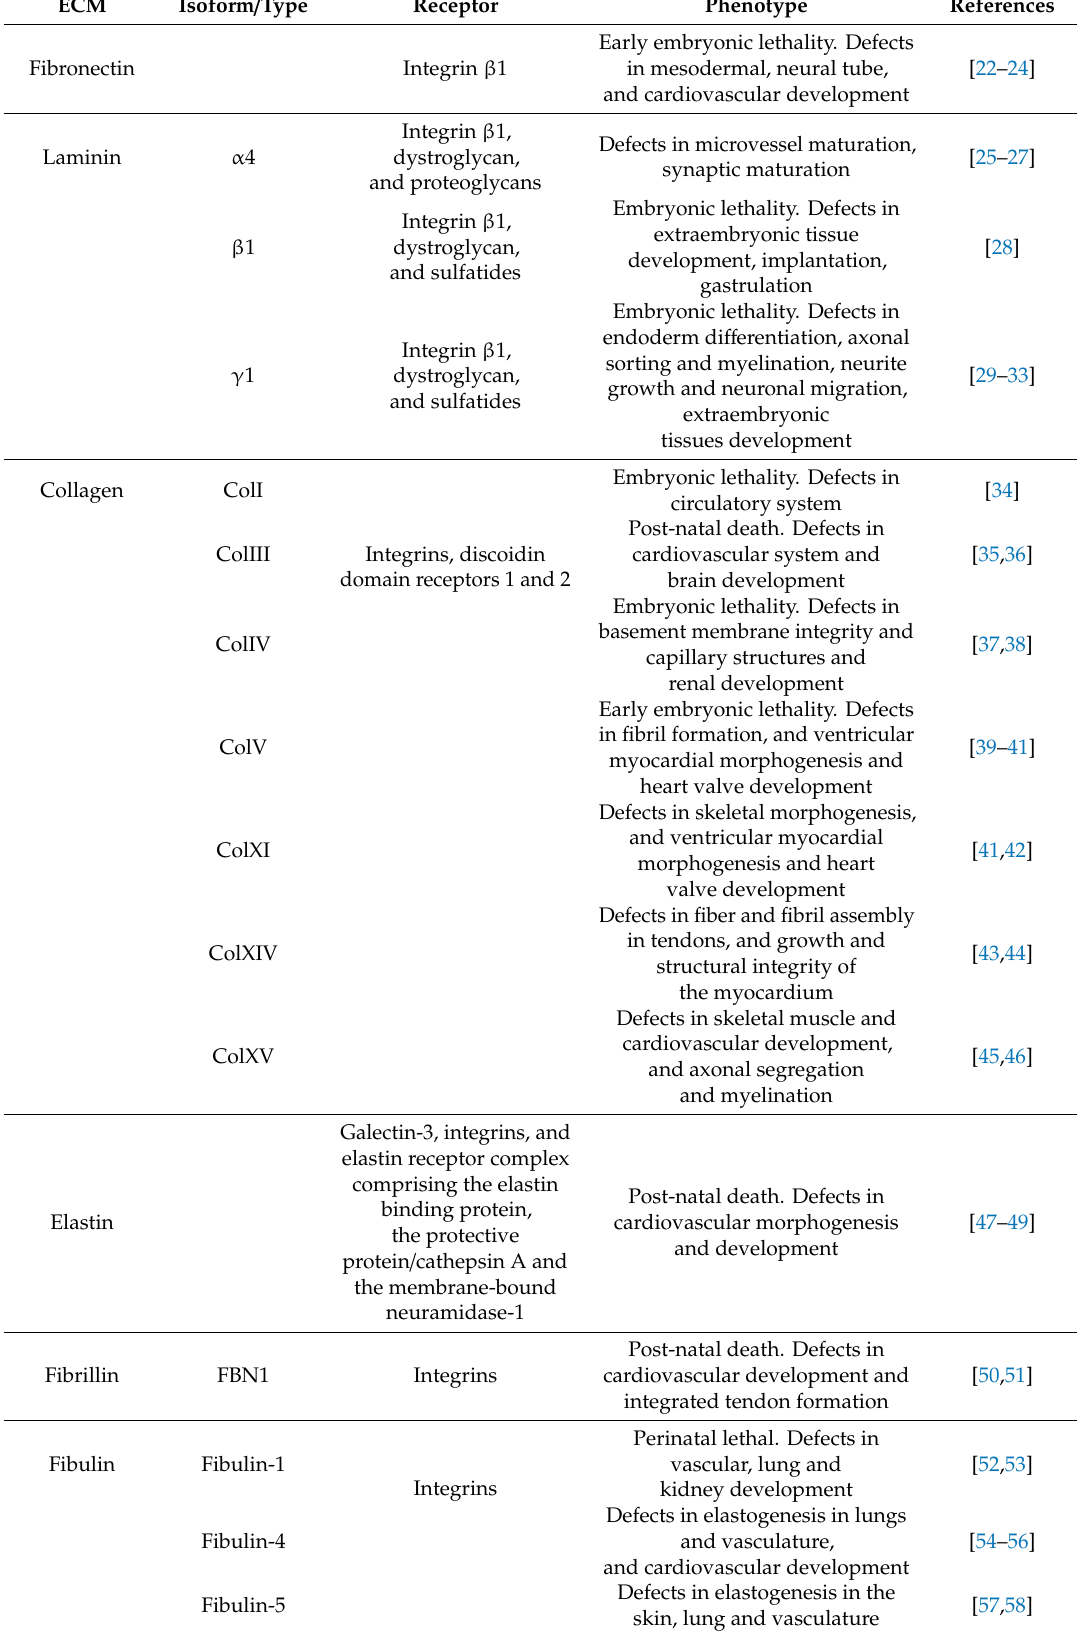
Table 1. ECM loss-of-function phenotypes in mammalian